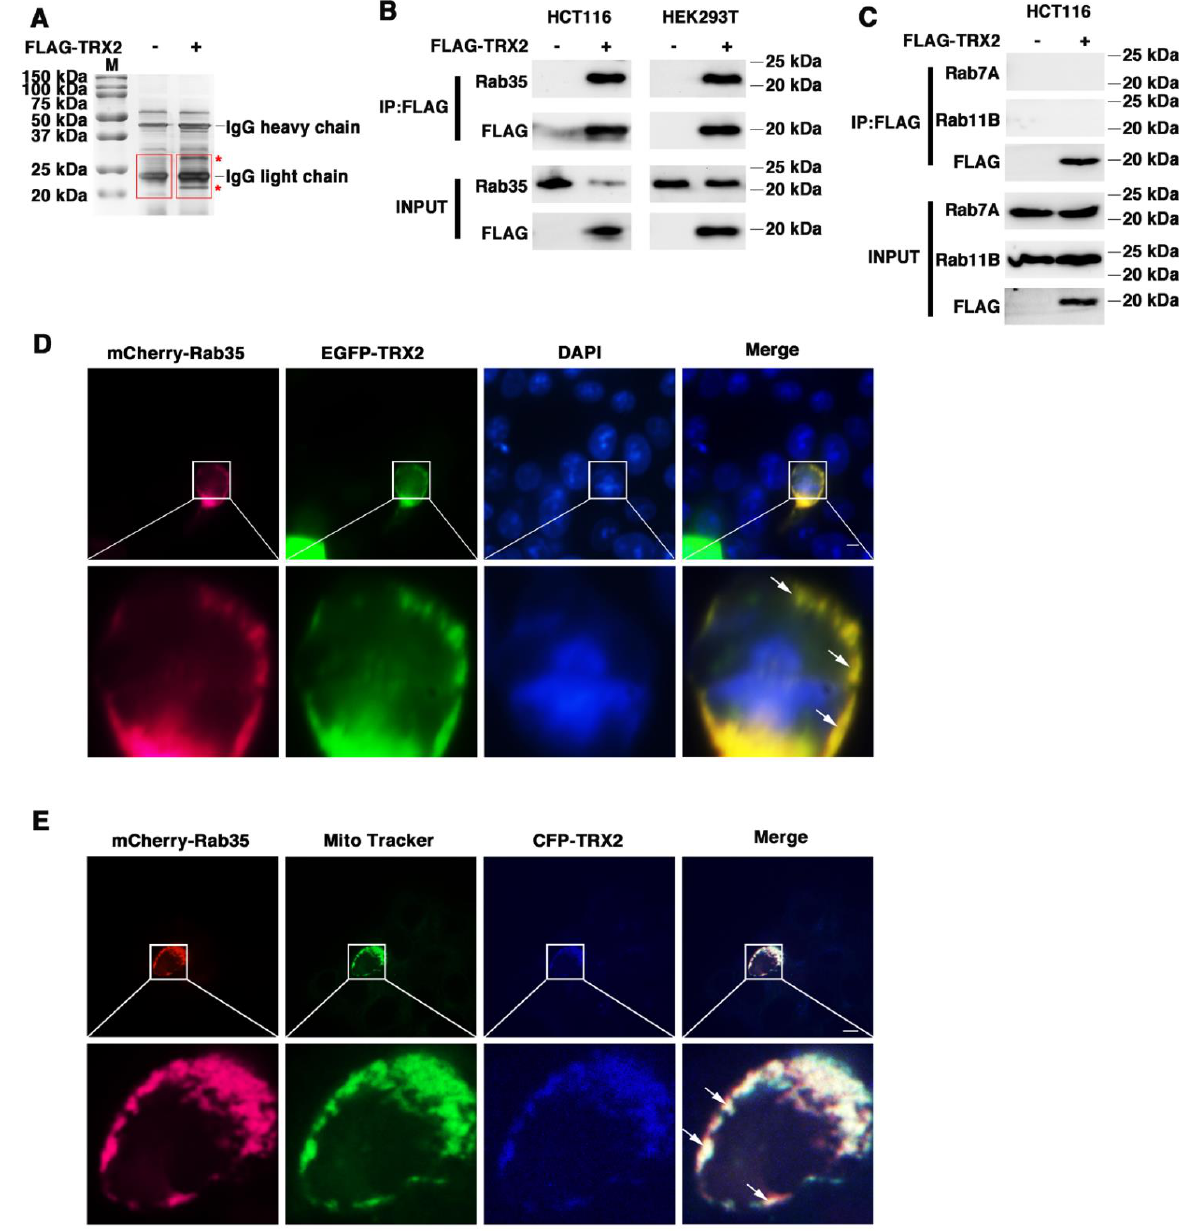
Figure 2. TRX2 interacted with Rab35 and they colocalized on mitochondria. ( A ) Silver staining. IP was performed with anti − FLAG magnetic beads. The * represents the specific protein bands of HCT116 cells transfected with FLAG − TRX2. The red boxes represent the gel piece excised for mass spectrometry. ( B ) HCT116 and HEK293T cells were transfected with pcDNA3.1+ or FLAG − TRX2. After 72 h, coimmunoprecipitation was performed, and Rab35 was detected. ( C ) HCT116 cells were transfected with pcDNA3.1+ or FLAG − TRX2. After 72 h, coimmunoprecipitation was performed, and Rab7A and Rab11B were detected. ( D ) HCT116 cells were transfected with EGFP − tagged TRX2 and mCherry − tagged Rab35. Rab35 (magenta), TRX2 (green), and nuclei (blue) are shown separately or merged. The scale bar = 10 μm. Magnification (lower panels) was ×5. ( E ) HCT116 cells were transfected with mCherry − tagged Rab35 or both mCherry − tagged Rab35 and CFP − tagged TRX2. After 48 h, the mitochondria were labelled with MitoTracker Green. Rab35 (magenta), mitochondria (green), and TRX2 (blue) are shown separately or merged. The experiments were performed for three biological replicates. The scale bar = 10 μm. Magnification (lower panels) was ×5.